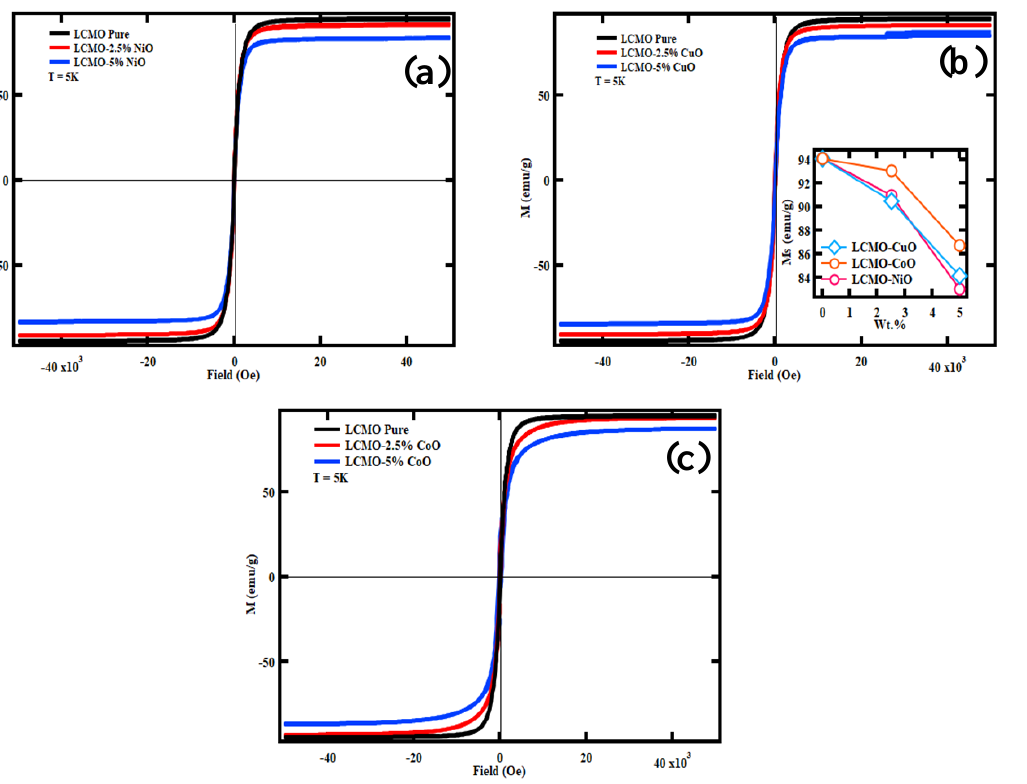
Figure 4. Magnetic hysteresis loop (M vs. H) of LCMO-MO composite samples ( a ) LMCO- x % NiO, ( b ) LCMO- x % CuO, and ( c ) LCMO- x %CoO at 5 K. The inset in figure ( b ) is showing the saturation of magnetization with weight percentage.